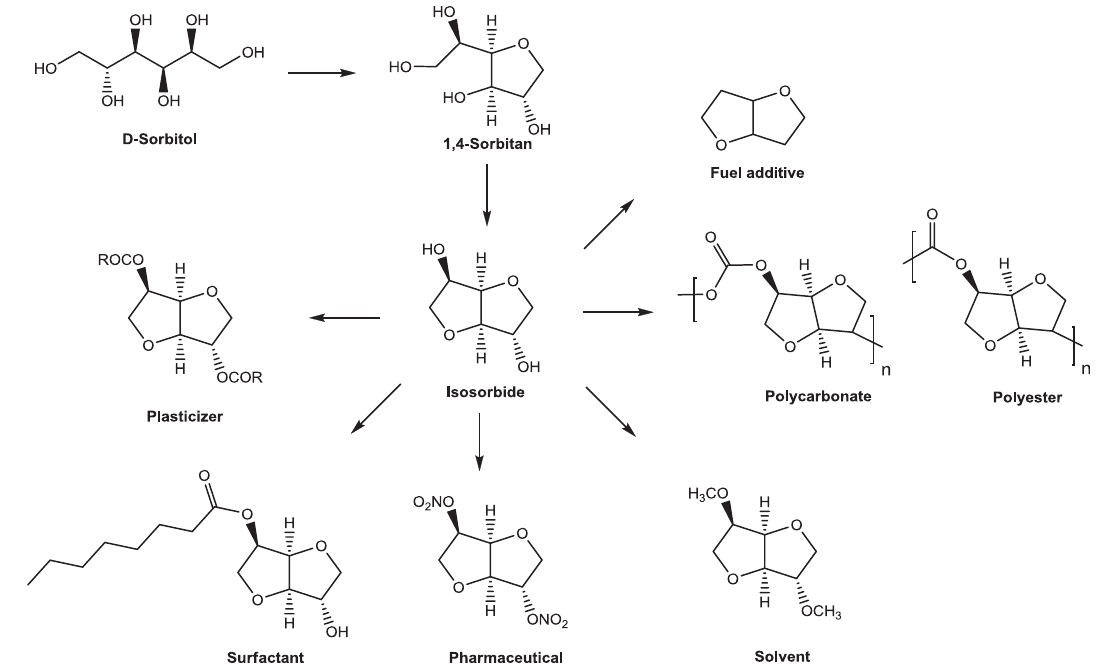
Figure 1. Synthesis and applications of isosorbide.